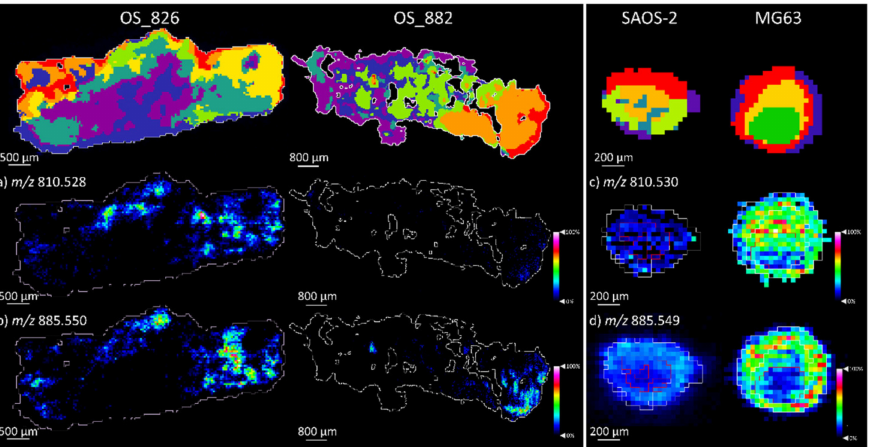
Figure 9. Phospholipid species detected within OS human tissue and OS aggregoid models. Ion density maps of metabolites in OS patient_826 and OS patient_882. Scale bar 500 µ m and 800 µ m, respectively. Ion density maps of aggregoid models outlining the core and outer area. Scale bar 200 µ m. Peaks identified in human tissue ( a ) m / z 810.528, PS 38:4; ( b ) m / z 885.550, PI 38:4. Peaks identified in OS models ( c ) m / z 810.530, PS 38:4; ( d ) m / z 885.549, PI 38:4. Mean intensity bar graph for each included in Supplementary Figure